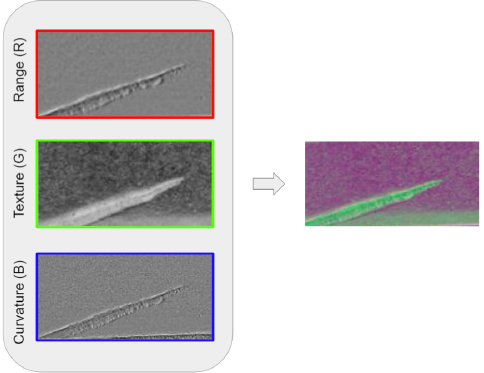
Figure 4. RGB image with the selected layers of photometric stereo acquisition.